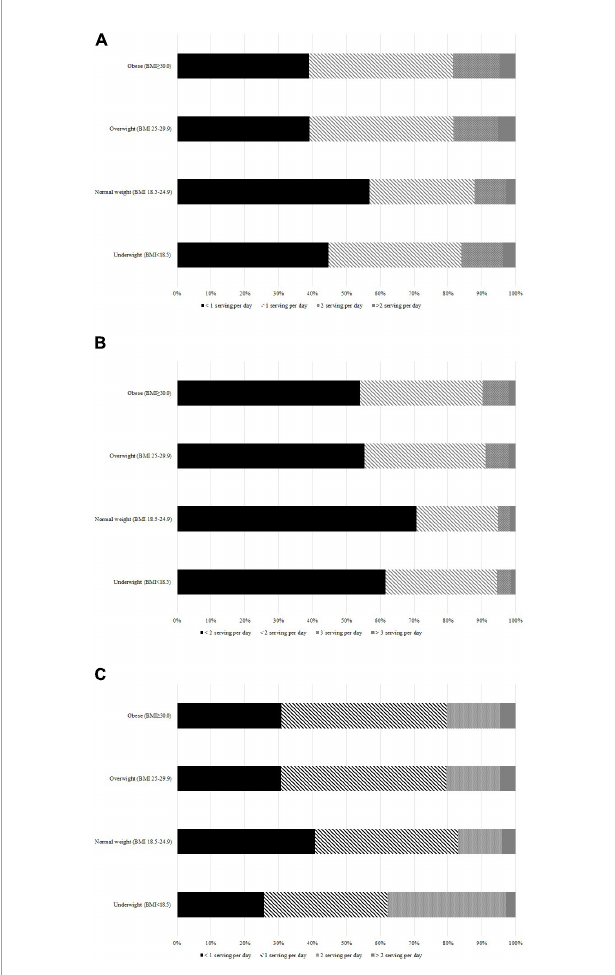
FIGURE2 The percent of fruits, vegetables and dairy products serving per day based on the body mass index (BMI) classification from the Stepwise approach to surveillance (STEPS) 2016 study in Iran. (A) The percent of fruits consumptions from the STEPS 2016 study in Iran. (B) The percent of vegetables consumptions from the STEPS 2016 study in Iran. (C) The percent of dairy products consumptions from the STEPS 2016 study in